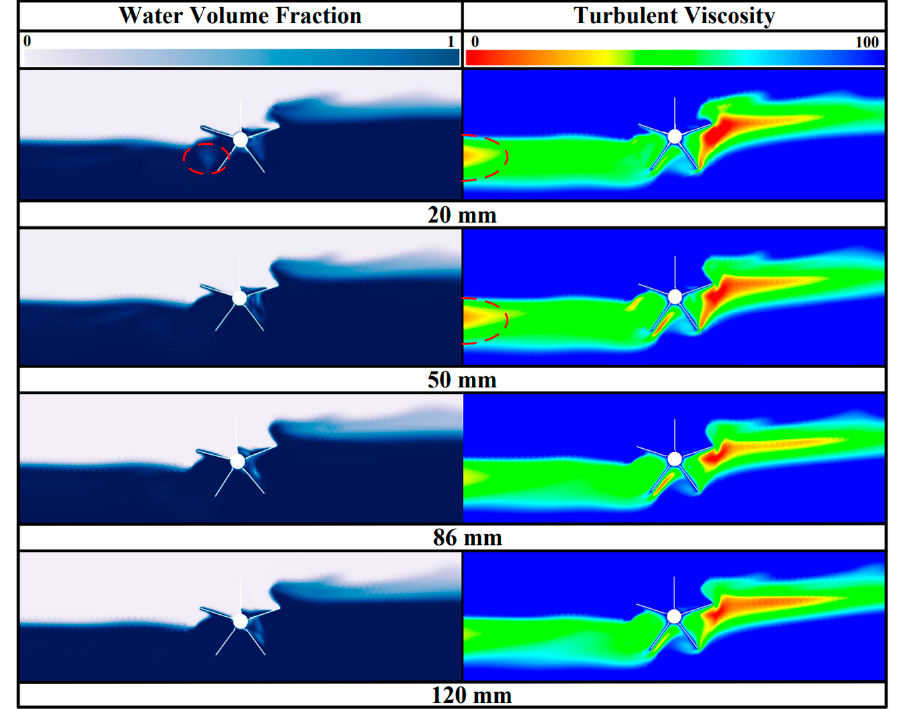
Figure 8. Profiles of water volume fraction and turbulent viscosity of water wheels under different clearance effects at circumferential angle θ = 288°.